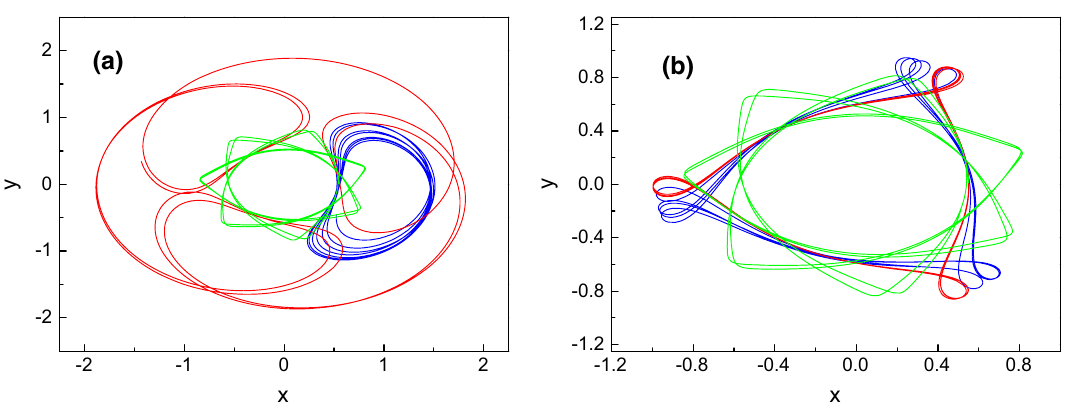
Fig. 10 Orbit 1 in Newtonian case (green curve), 1PN truncated system (red curve), and the exact non-truncated system (blue curve) with: a a = 30; b a = 100